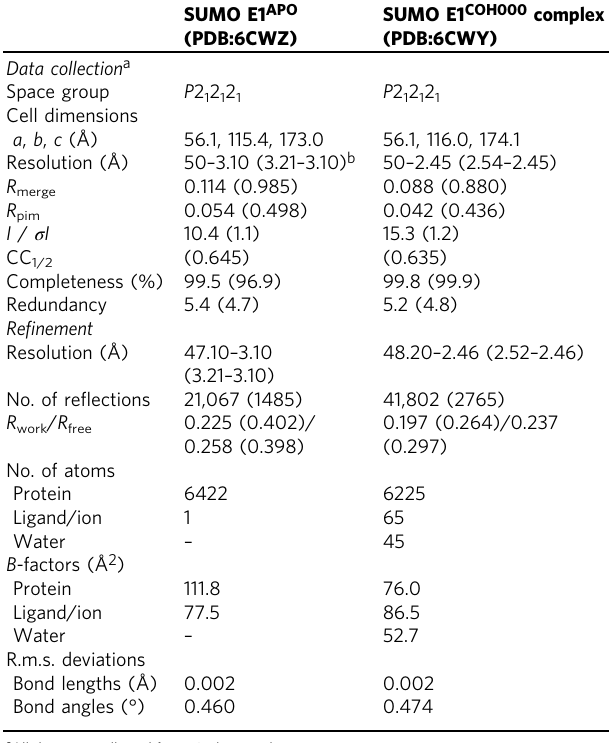
Table 1 Data collection and re fi nement